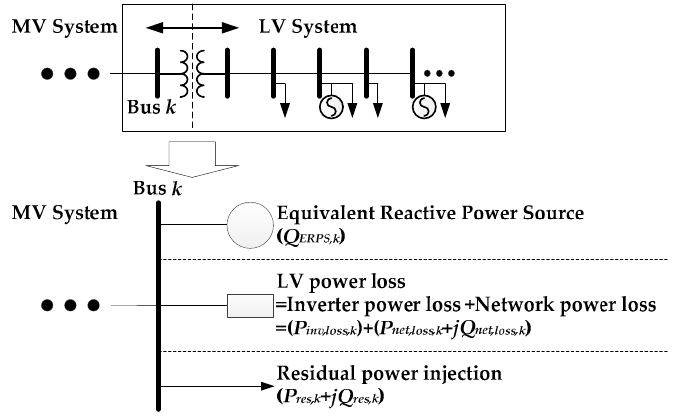
Figure 1. Proposed model for a low-voltage (LV) system.